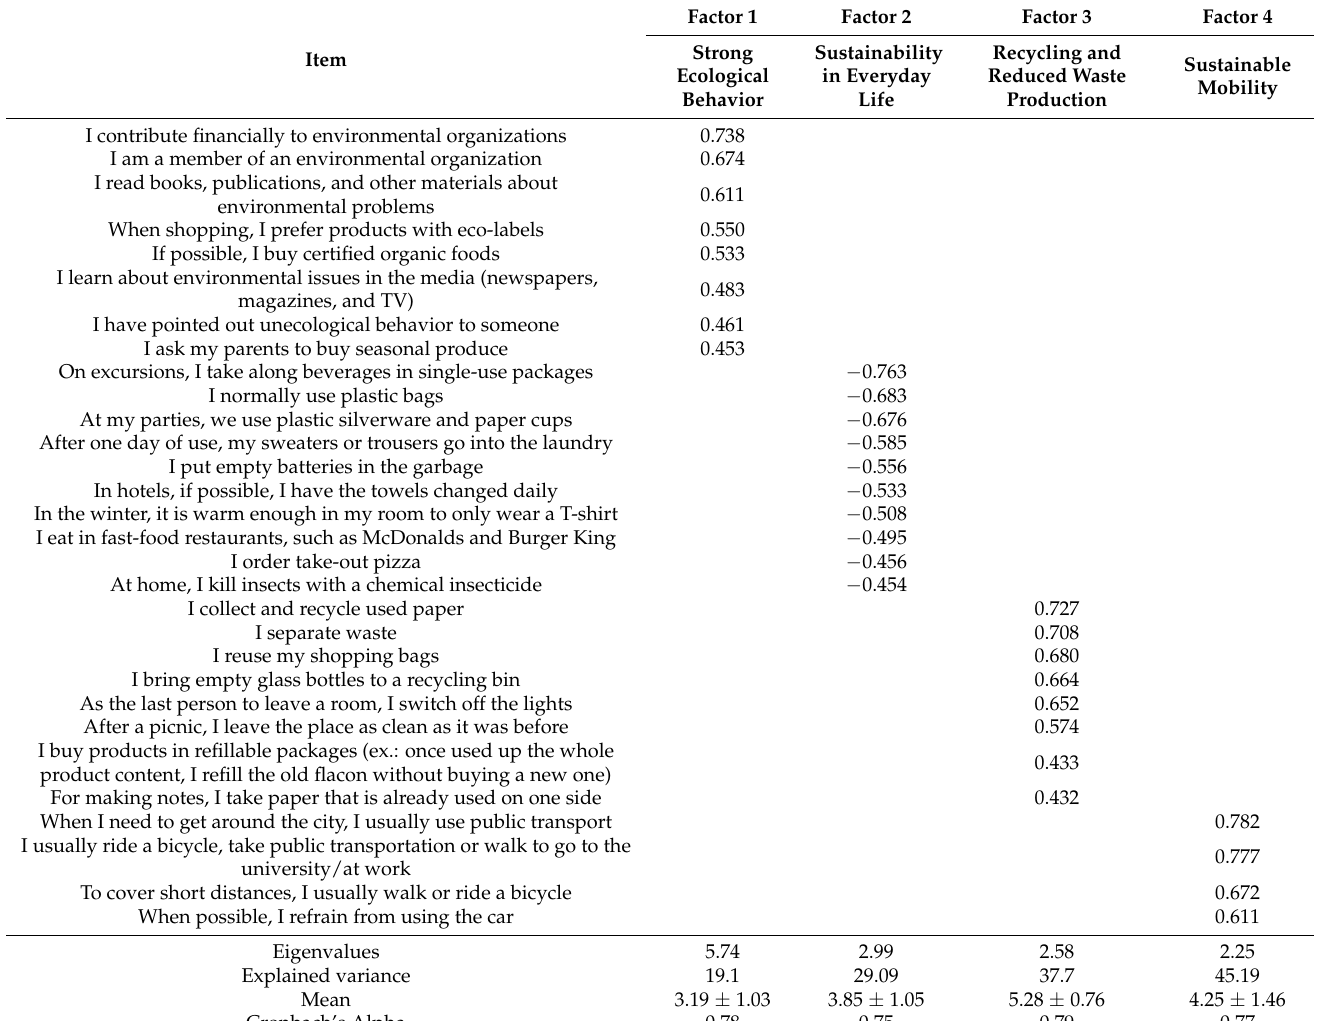
Table 2. EFA: results and factors loadings for GEB